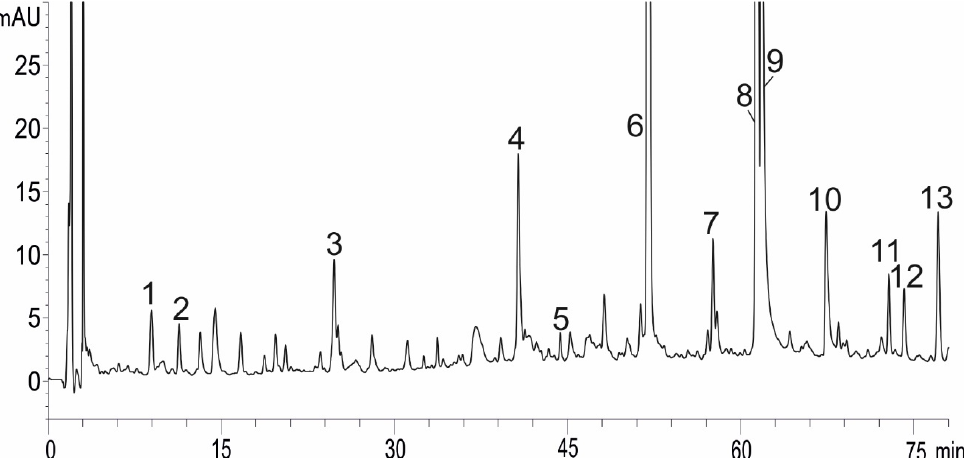
Figure 3. Chromatogram of Melissa officinalis leaf extract (control plants) with peaks identified by HPLC-UV-MS. (1) 3- (3,4-dihydroxyphenyl)-lactic acid; (2) caftaric acid; (3) fertaric acid; (4) caftaric acid hexoside; (5) rosmarinic acid hexoside; (6) rosmarinic acid; (7) salvianolic acid H/I (isomer); (8) salvianolic acid C derivative III; (9) lithospheric acid; (10) salvianolic acid C derivative III; (11) salvianolic acid C derivative IV; (12) sagecoumarin 2-hydroxy-3-(3,4-dihydroxyphenyl)-propanoide; and (13) methyl lithospermic acid.